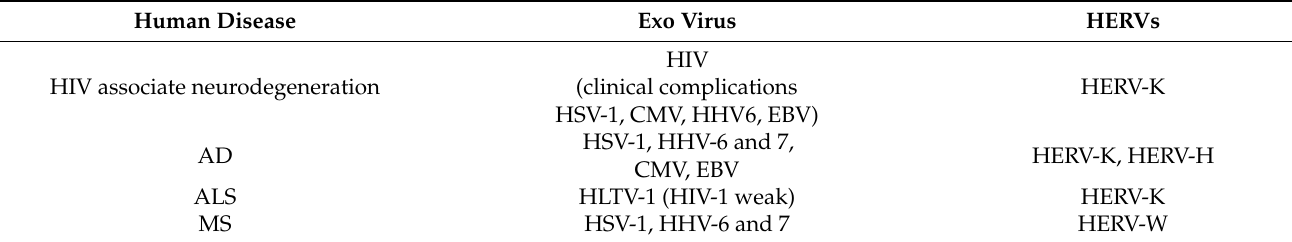
Table 1. Exogenous virus (Exo virus) and endogenous retrovirus (HERV) association with human diseases of the central nervous system. Human